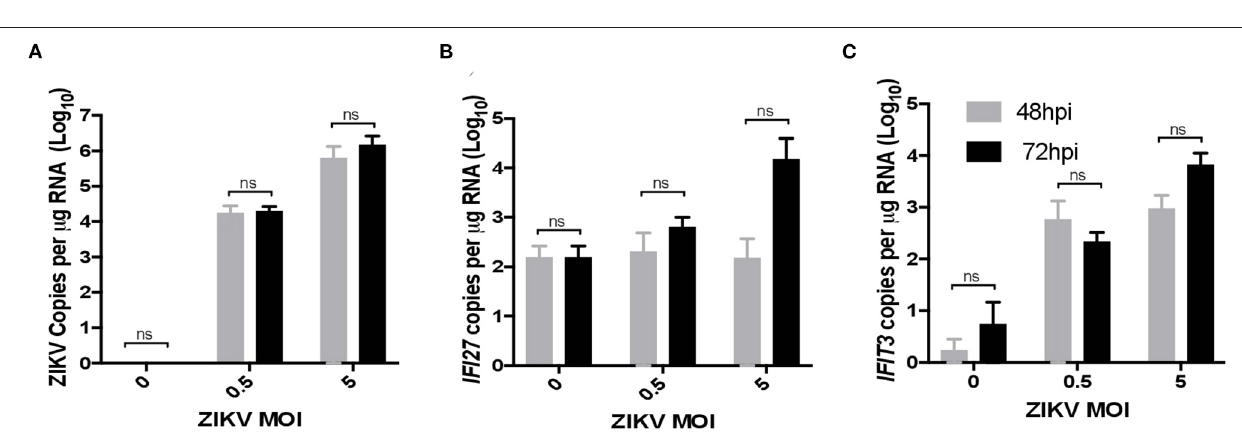
FIGURE 7 | ZIKV infection in vitro induces IFI27 expression in human placenta. CD14 + cells were isolated from de-identified human full-term placentas and infected with ZIKV (MOIs = 0.5 and 5 FFU/cells) at 48 and 72 hpi supernatants were collected and analyzed by qRT-PCR for expression of (A) ZIKV (B) IFI27 (C) IFIT3. A two-way ANOVA with secondary testing was used to determine statistical significance for these